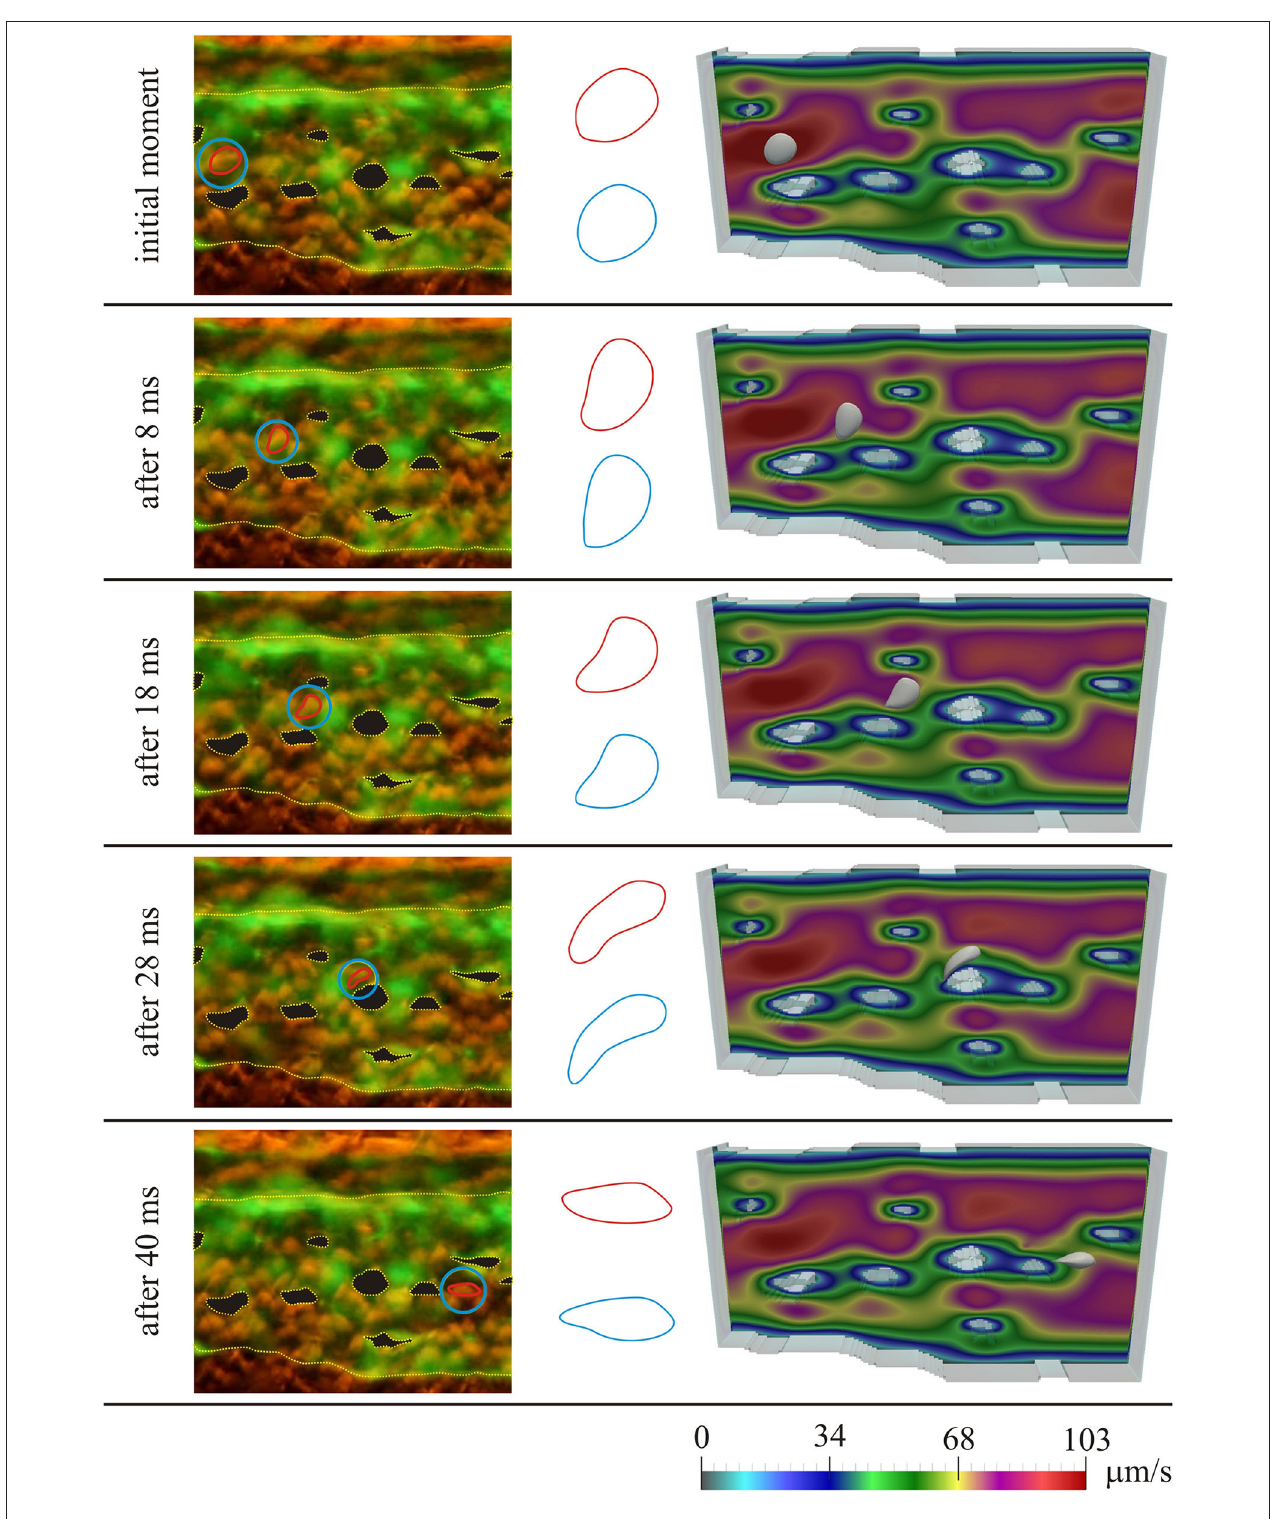
FIGURE 3 | Comparison of experimental results with results obtained using numerical simulation, for the first initial position of the RBC; left—microscopic image of the zebrafish, with denoted considered RBC; middle—isolated shapes of the considered RBC (red—experiment; blue—simulation); right—results obtained using numerical simulation. Colors on the images obtained using numerical simulations denote the intensity of the blood velocity, according to the scale bar at the bottom of the Figure. The blood flow through capillary plexus of the living zebrafish was observed 32h post fertilization.